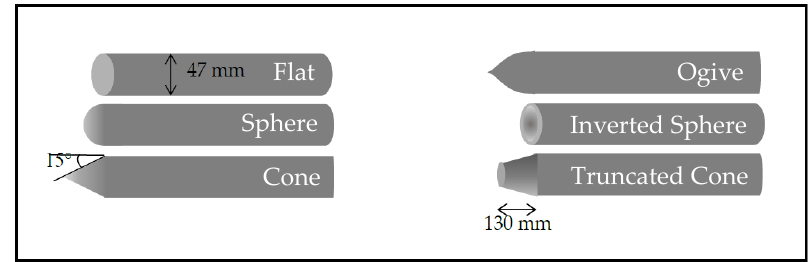
Figure 3. The examined supercavitation bodies.